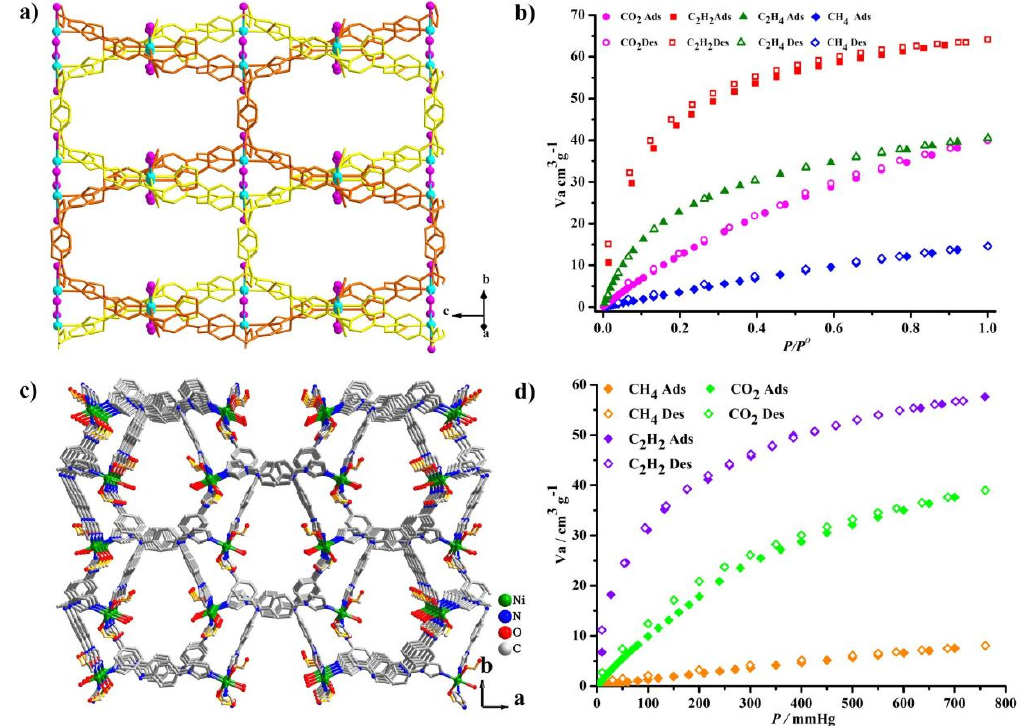
Figure 6. ( a ) A simple framework containing two Cd-TIPA frameworks linked by µ 2 -Cl − ions. ( b ) C 2 H 2 , C 2 H 4 , CH 4 and CO 2 sorption isotherms at 297 K. Reproduced with permission [60]. Copyright 2014, the American Chemical Society. ( c ) 3D framework of compound [Ni (TIPA)(COO − )2(H 2 O)] ∙ 2(DMF)2(H 2 O) along the c axis. ( d ) adsorption isotherms of CO 2 , CH 4 and C 2 H 2 at 297 K. Reproduced with permission [63]. Copyright 2018, Royal Society of Chemistry.